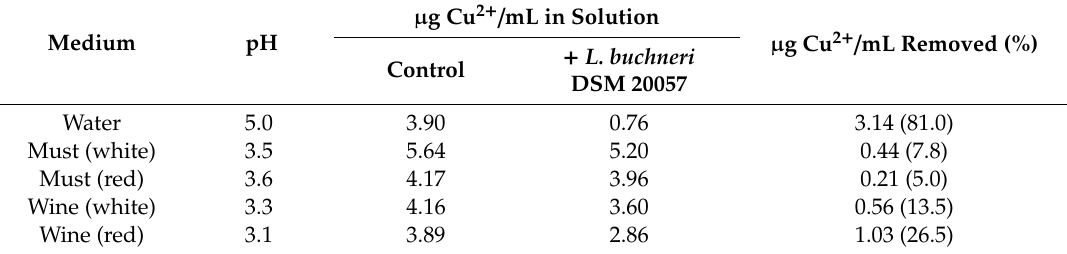
Table 3. Removal of copper from must and wine by living biomass of L. buchneri DSM